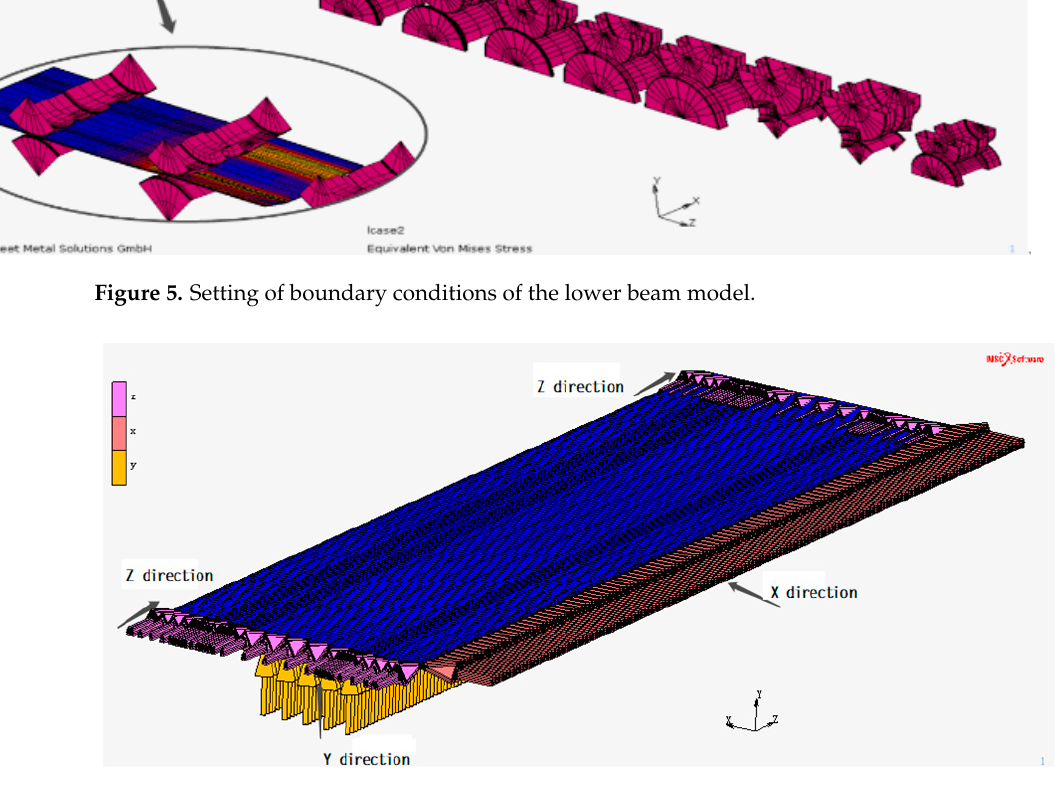
Figure 6. Three-dimensional cold-bending model of automobile lower beam. Table 4. Geometric factor parameter